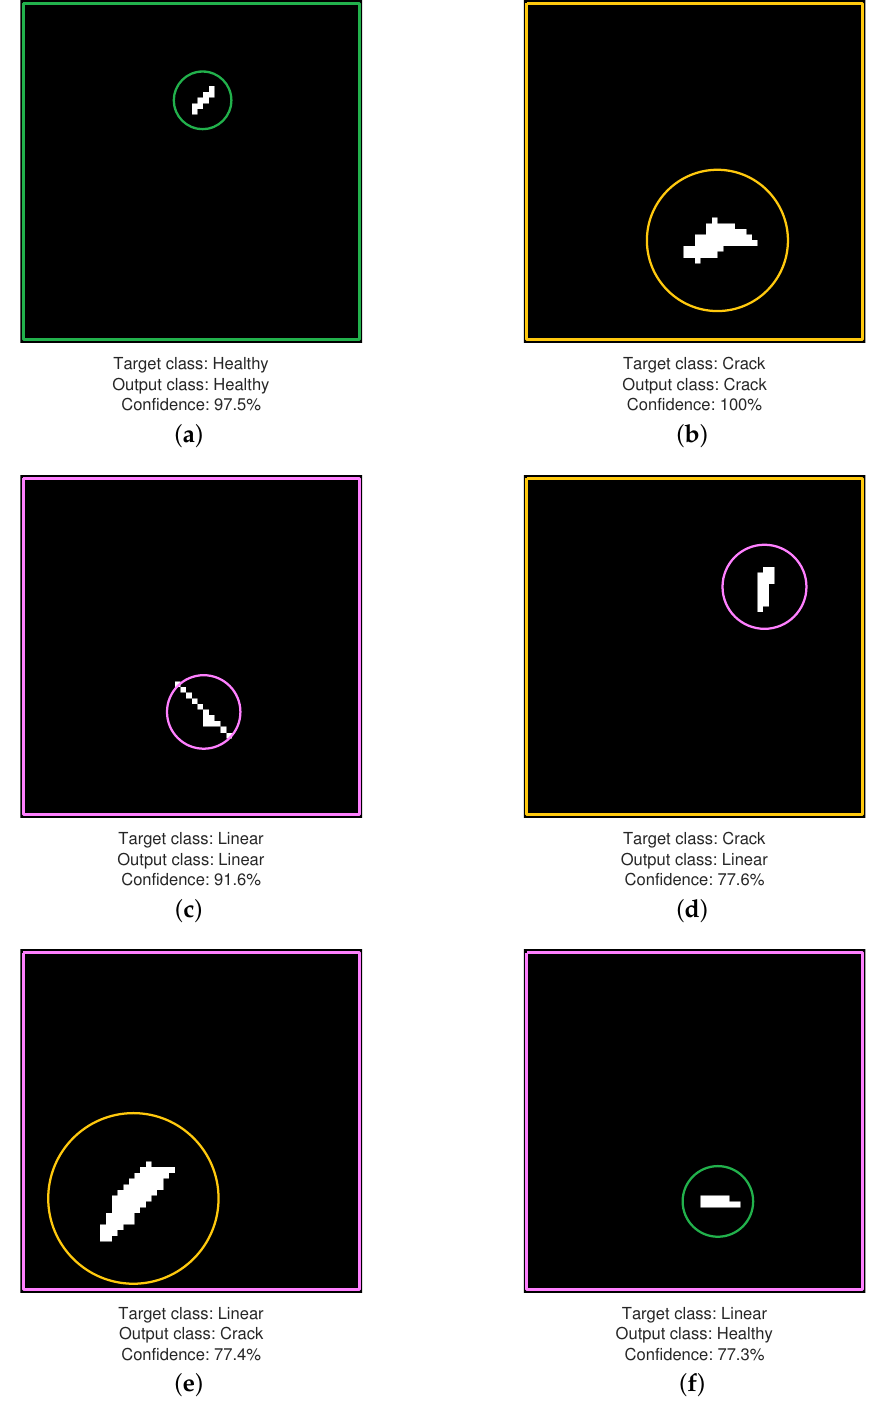
Figure 15. Classificationexamples: the colour of the boundary of the image is relative to the target class, while the colour of the circle is relative to the predicted class: ( a ), ( b ) and ( c ) shows examples of correct classification, while ( d ), ( e ) and ( f ) shows